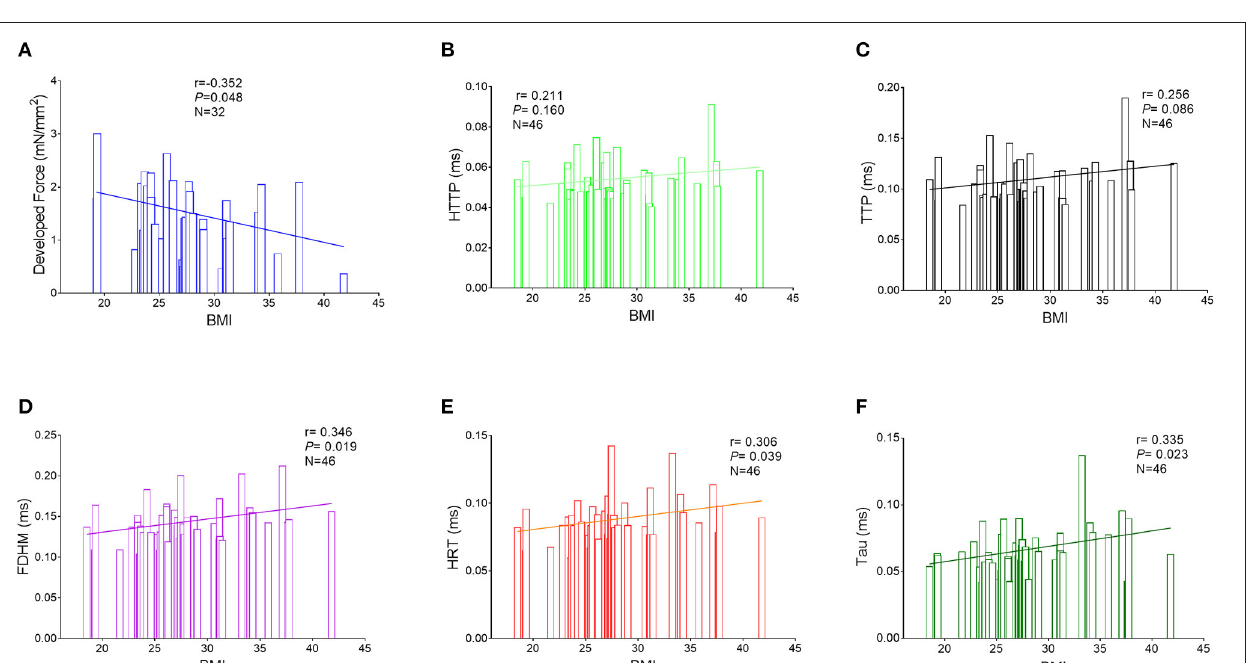
by isoproterenol (lusitropy) in the obese group (BMI ≥ 30 kg/m 2 ) was significantly smaller compared to the normal group with BMI (18.5 kg/m 2 ≤ BMI < 25 kg/m 2 ) ( Figure 4